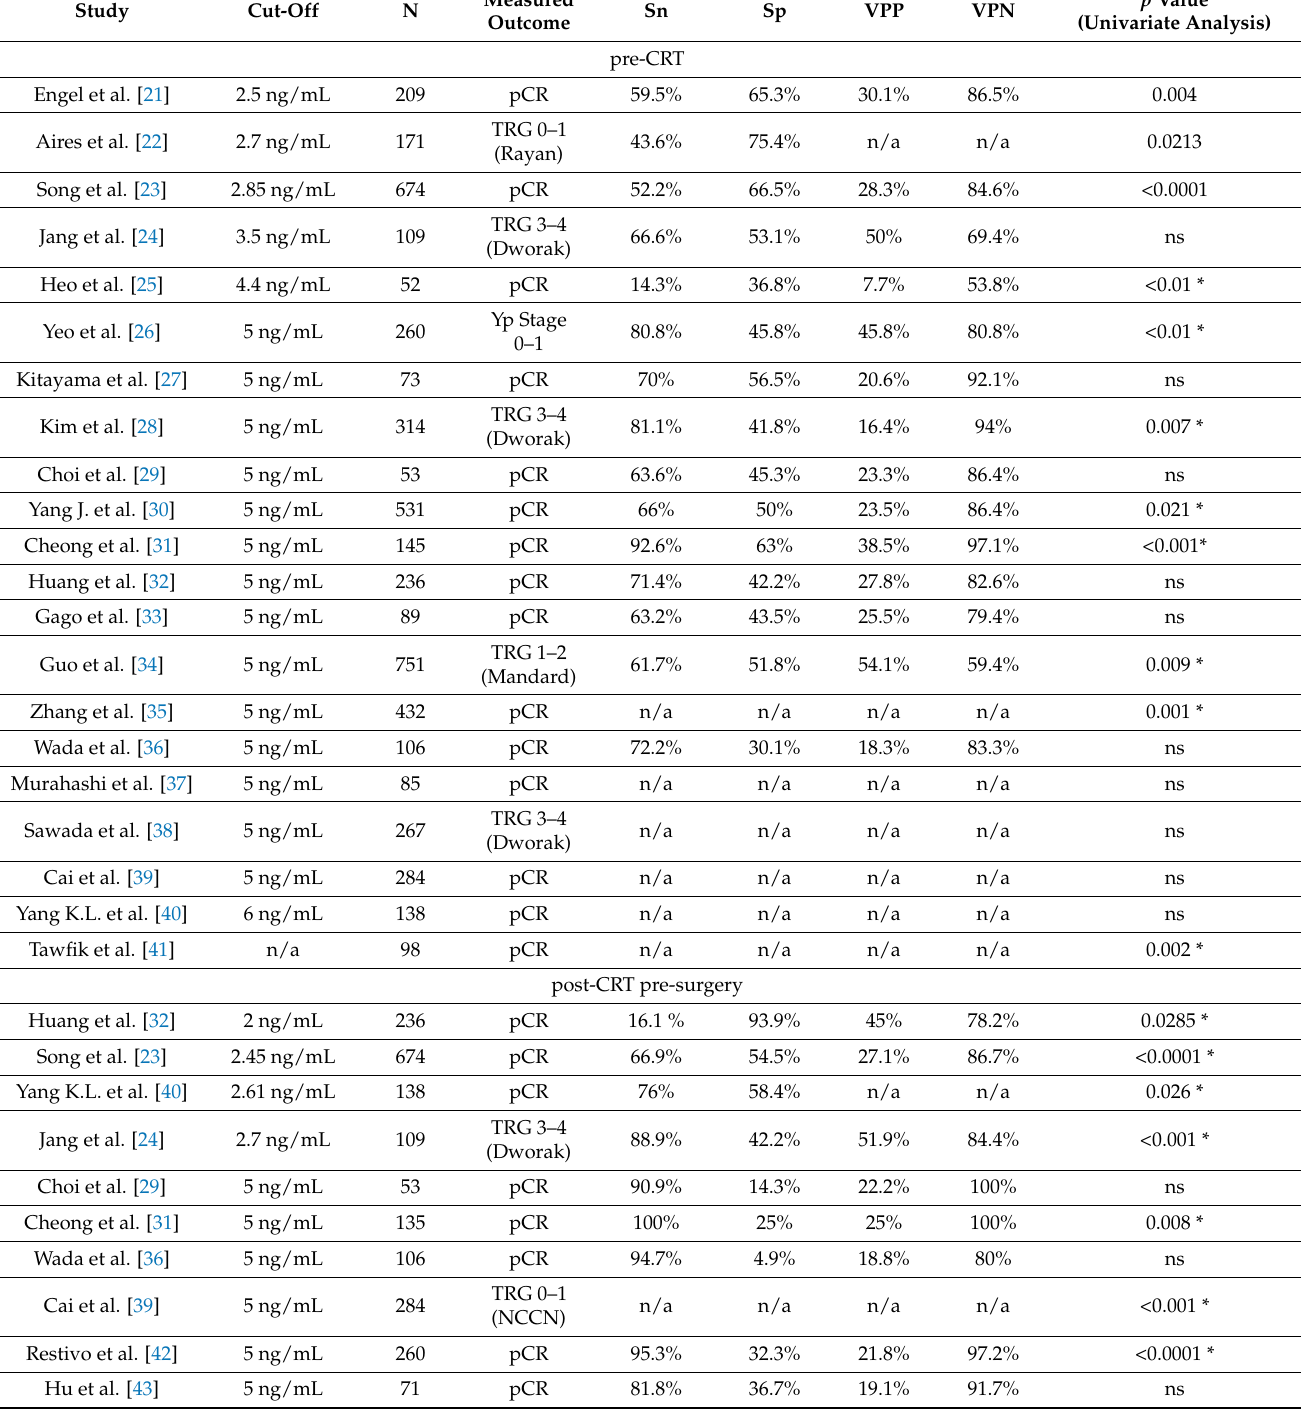
Table 1. Studies exploring CEA as a biomarker predictive of tumor regression following